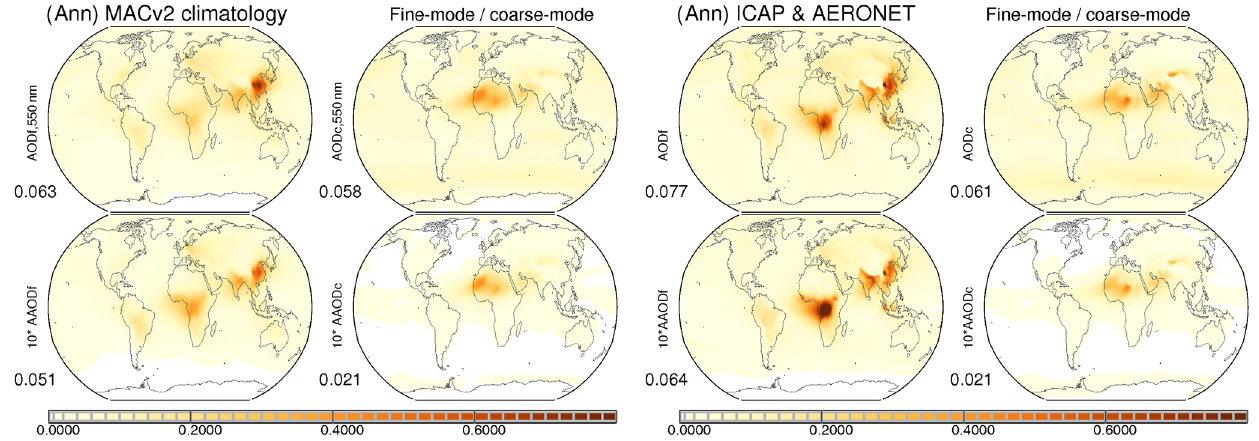
Figure 19. Estimates of today’s annual maps for tropospheric AODf, AODc, AAODf and AAODc by combining AERONET data with an AeroCom1 median (left frame) and with satellite AOD data assimilating ICAP averages (right frame). AAOD data are multiplied by 10. Values below labels show global averages.